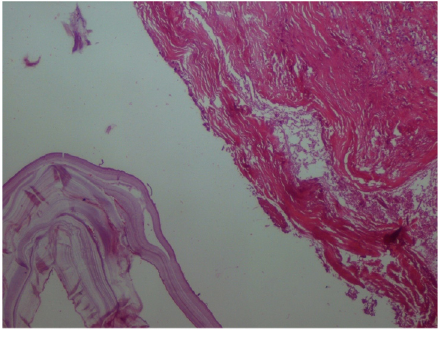
Figure 3. Microscopic appearance of the cyst wall. Haematoxylin and eosin, x40